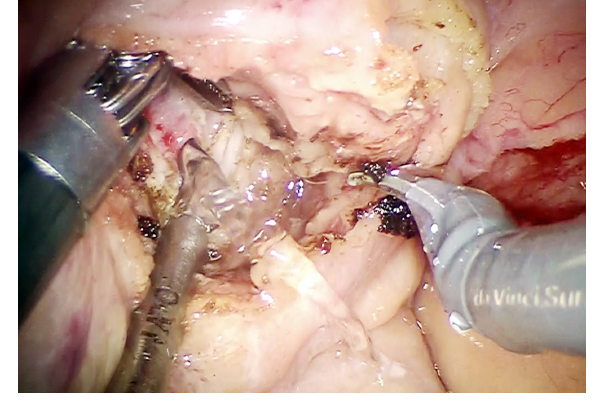
Figure 5. Cystotomy after local fat extirpation.